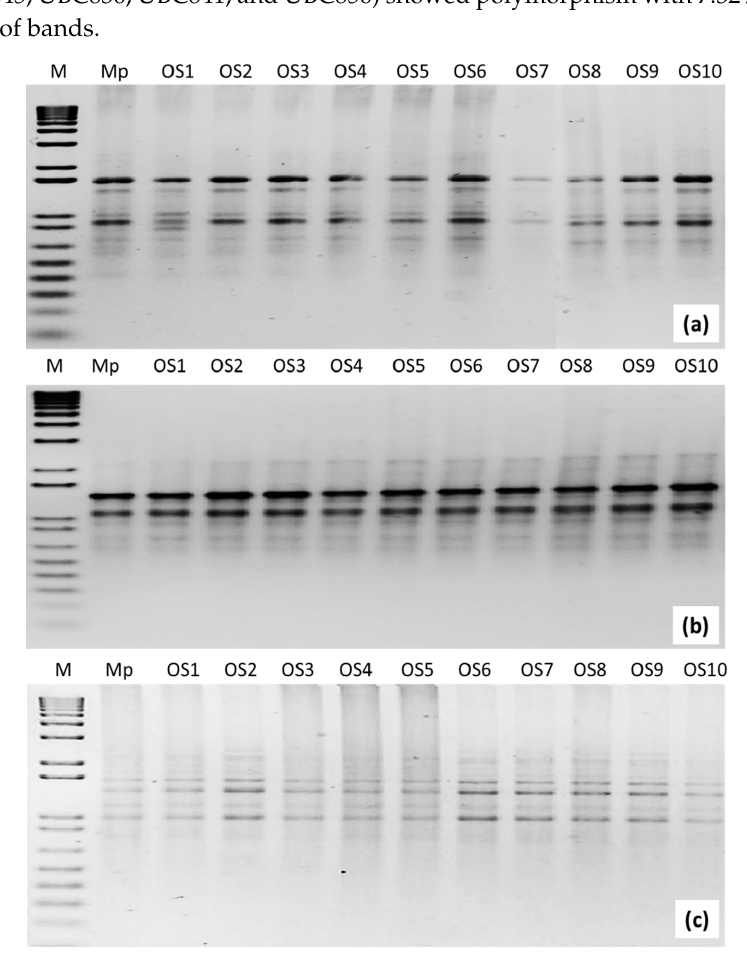
Figure 2. Polymerase chain reaction (PCR) amplification products obtained with inter-simple sequence repeat (ISSR) markers; ( a ) Primer UBC841, ( b ) Primer UBC835, and ( c ) Primer UBC855. Lane M: Molecular marker (100 bp–15 kbp); Lane Mp: Mother plant; Lanes OS1–OS10: In vitro-raised Ortosiphon stamineus Table 4. Primer used in ISSR polymorphism analysis, number and size of amplified fragments of Orthosiphon stamineus .